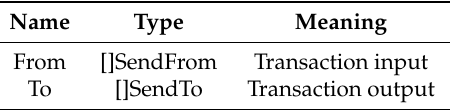
Table 2. Data structure of SendTx.